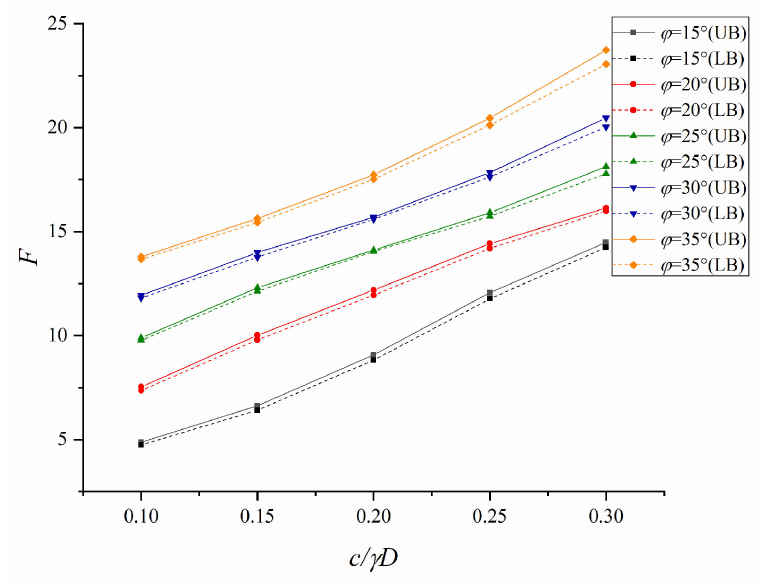
Figure 32. Influence of c/ γ D on the safety factors F of the global stability of adjacent construction under different ϕ ( C/D = 1, L/D =